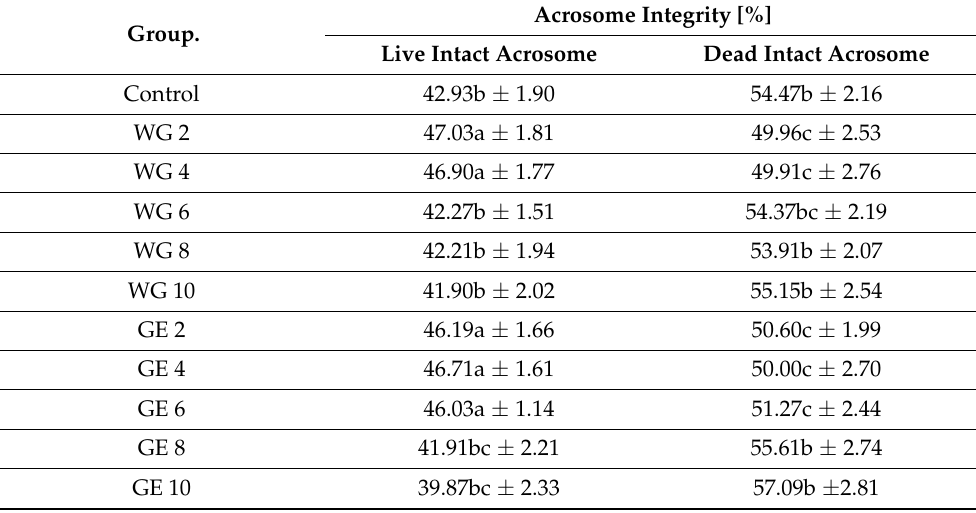
Table 3. Effect of various types of sea cucumber extract on the integrity of the sperm acrosome after cryopreservation. Explanations: a–d—means with different superscript letters in the same column differ significantly at p <